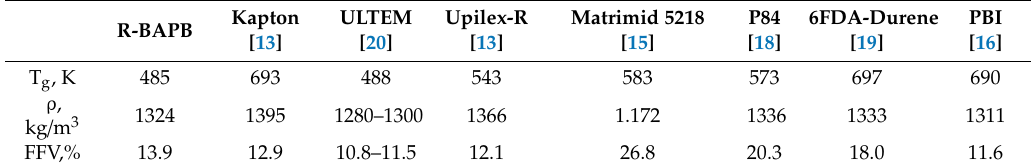
Table 1. Properties of R-BAPB and commercially available polyimides used in membrane gas